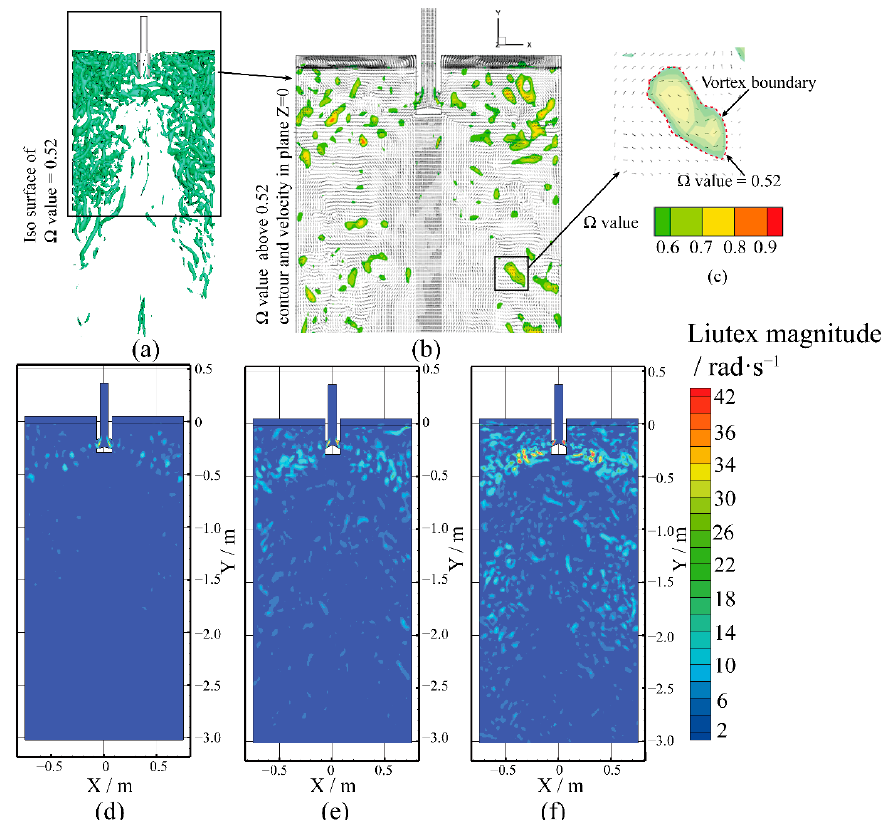
Figure 8. The typical features of vortex visualization in the mold. ( a ) Three-dimensional view, ( b ) two-dimensional view in the plane Z = 0, ( c ) the schematic of the vortex boundary recognition, and the Liutex magnitude under the case of ( d ) non-clog, ( e ) block rate 38.17%, ( f ) block rate 45.9%.